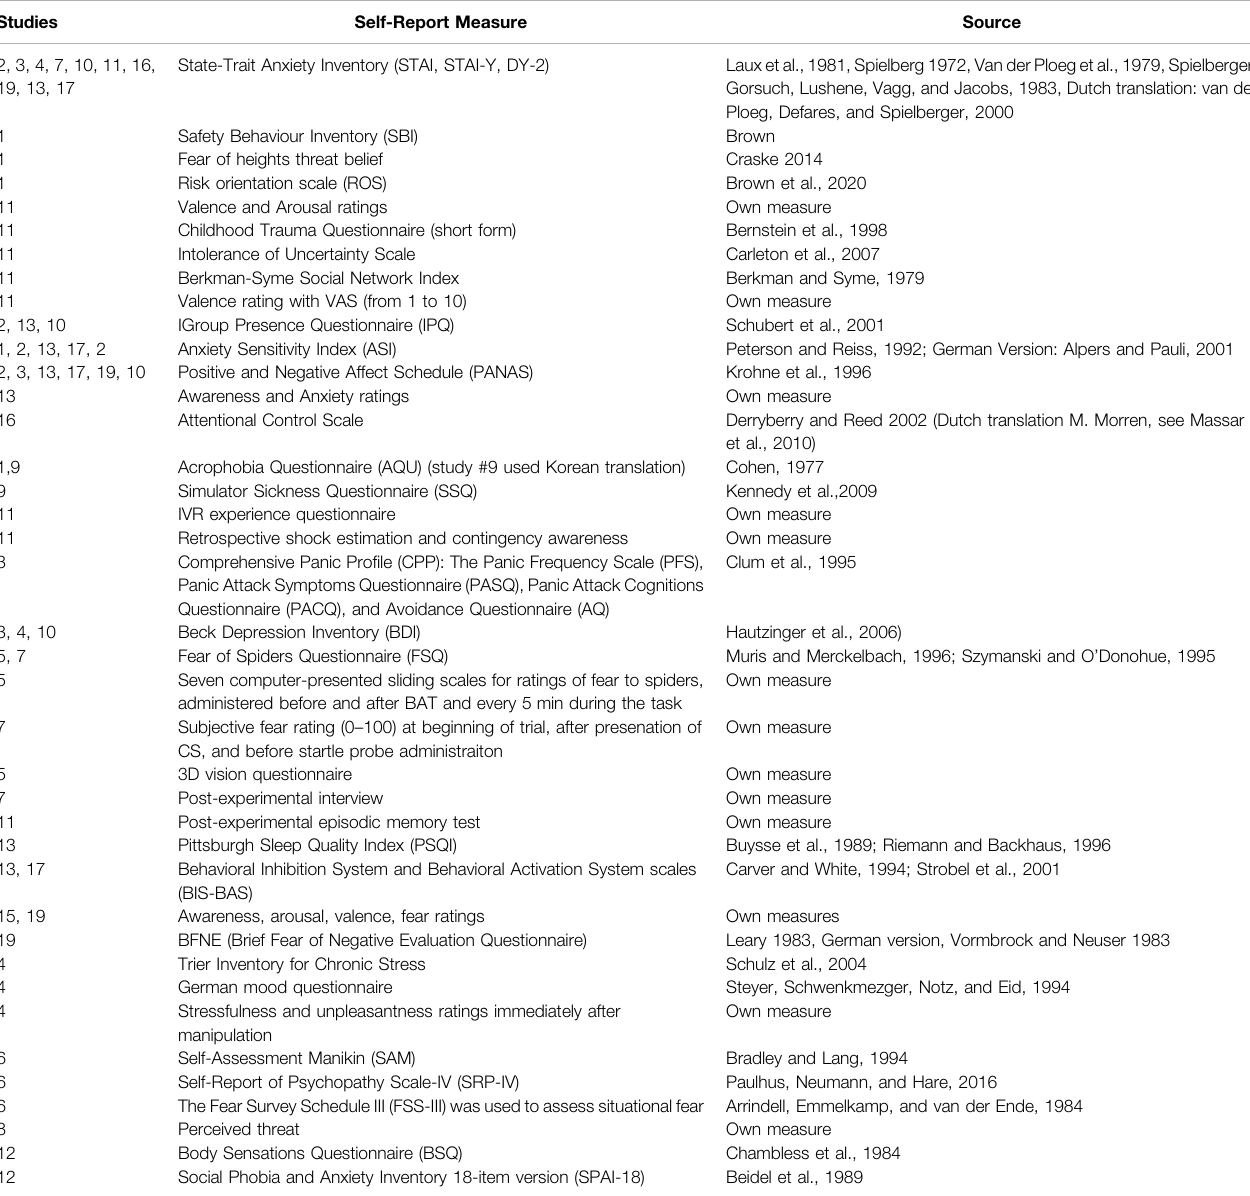
TABLE 1 | Self-report